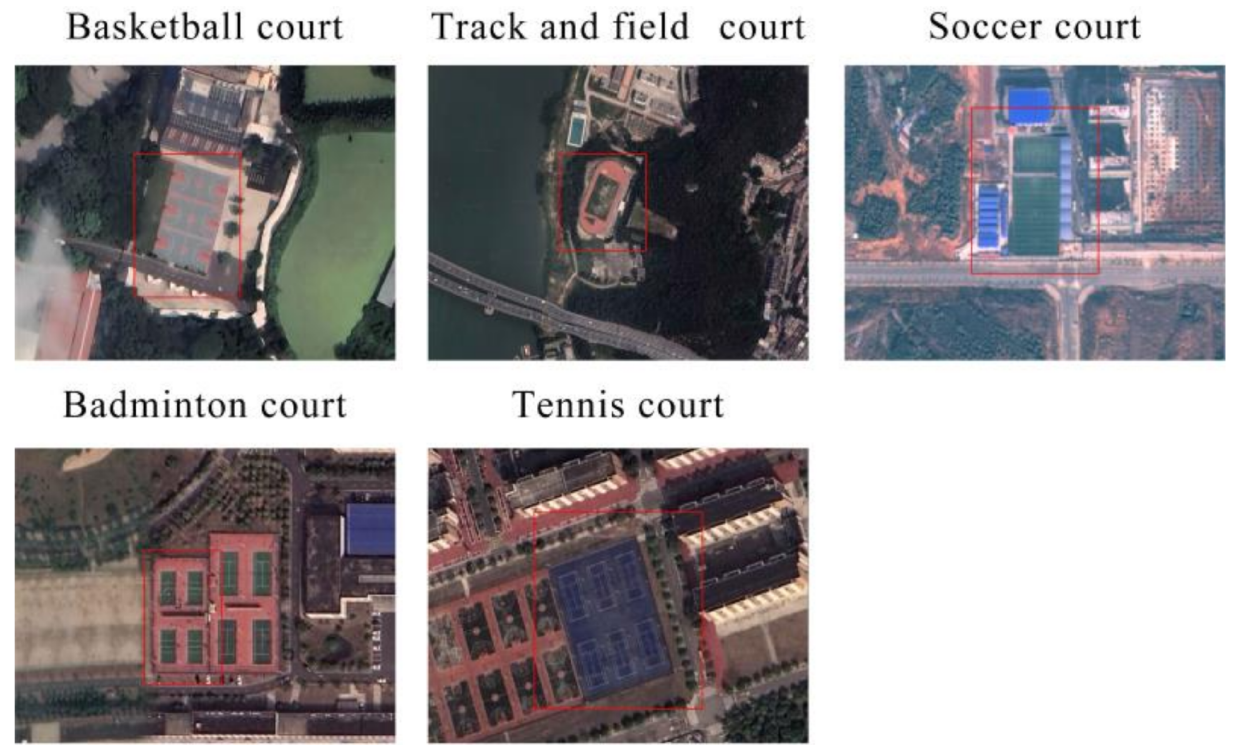
Figure 3. Remote sensing satellite images of each type of outdoor sports